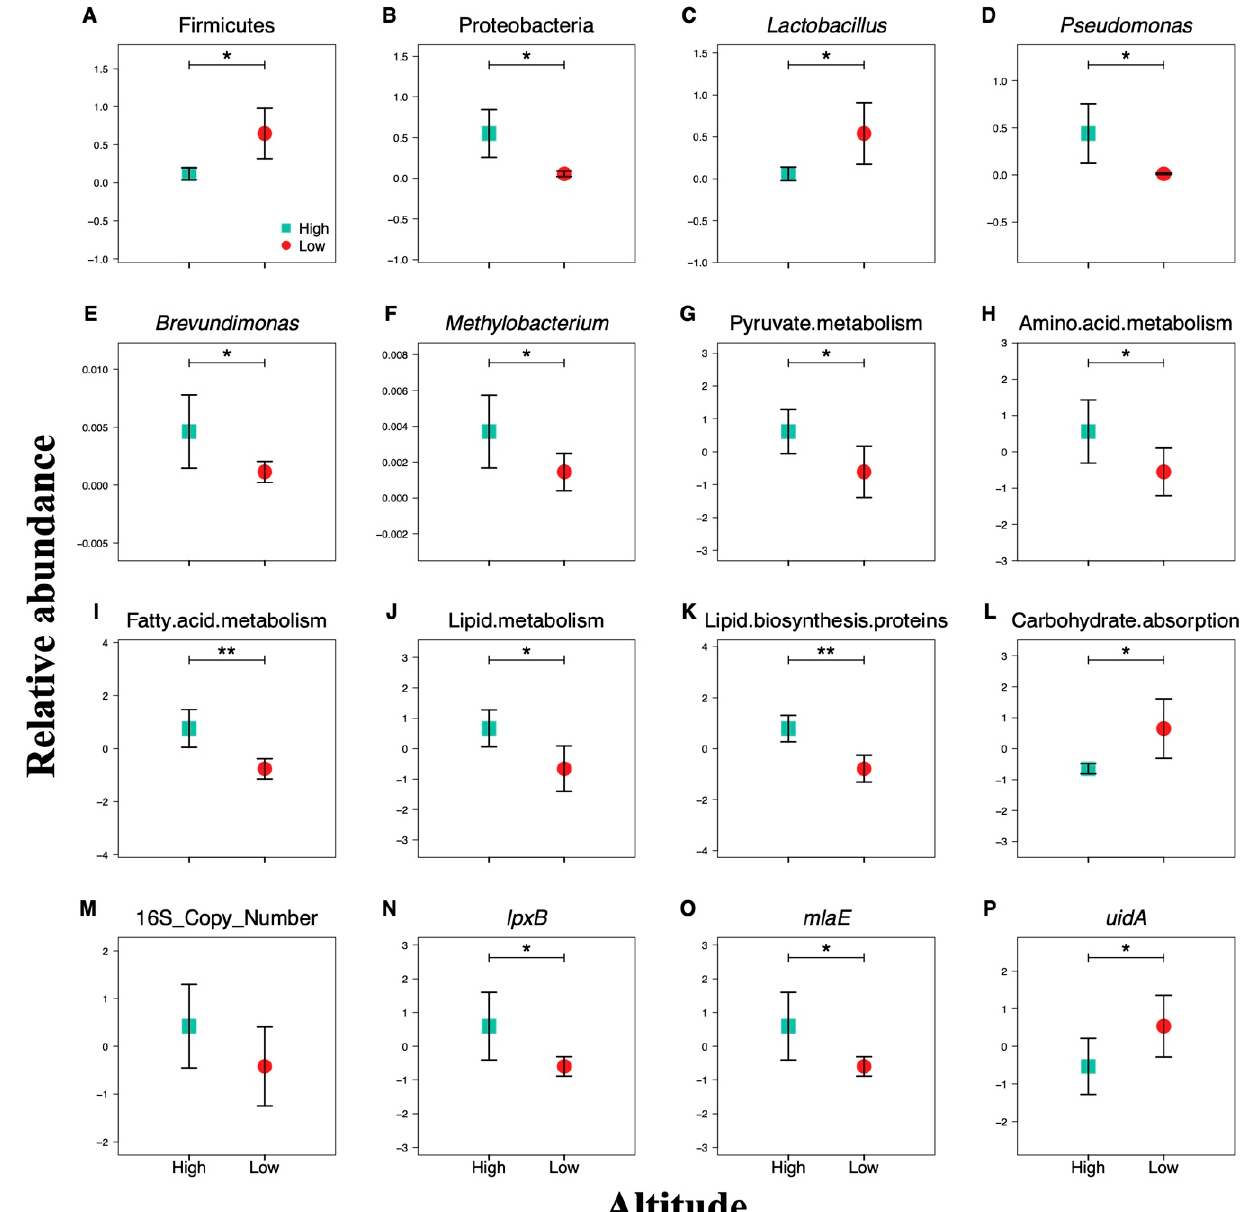
Figure 4. Altitude differences in the relative abundance of major sable gut bacterial phyla (( A ) Firmicutes; ( B ) Proteobacteria), genera (( C ) Lactobacillus; ( D ) Pseudomonas; ( E ) Brevundimonas; ( F ) Methylobacterium), KEGG pathway modules at level 3 (( G ) Pyruvate metabolism; ( H ) Amino acid metabolism; ( I ) Fatty acid metabolism; ( J ) Lipid metabolism; ( K ) Lipid biosynthesis proteins; ( L ) Carbohydrate absorption) and gene copies (qPCR) (( M ) The total bacterial 16S rRNA genes; ( N ) Lipid A disaccharide synthase related gene, lpxB; ( O ) Lipid asymmetry maintenance ABC transporter permease subunit related gene, mlaE; ( P ) Beta ‐ glucuronidase related gene, uidA). High indicates high altitude group, while Low indicates low altitude group. Asterisks indicate p ‐ value of < 0.01 (**) and < 0.05 (*) using t ‐ test.